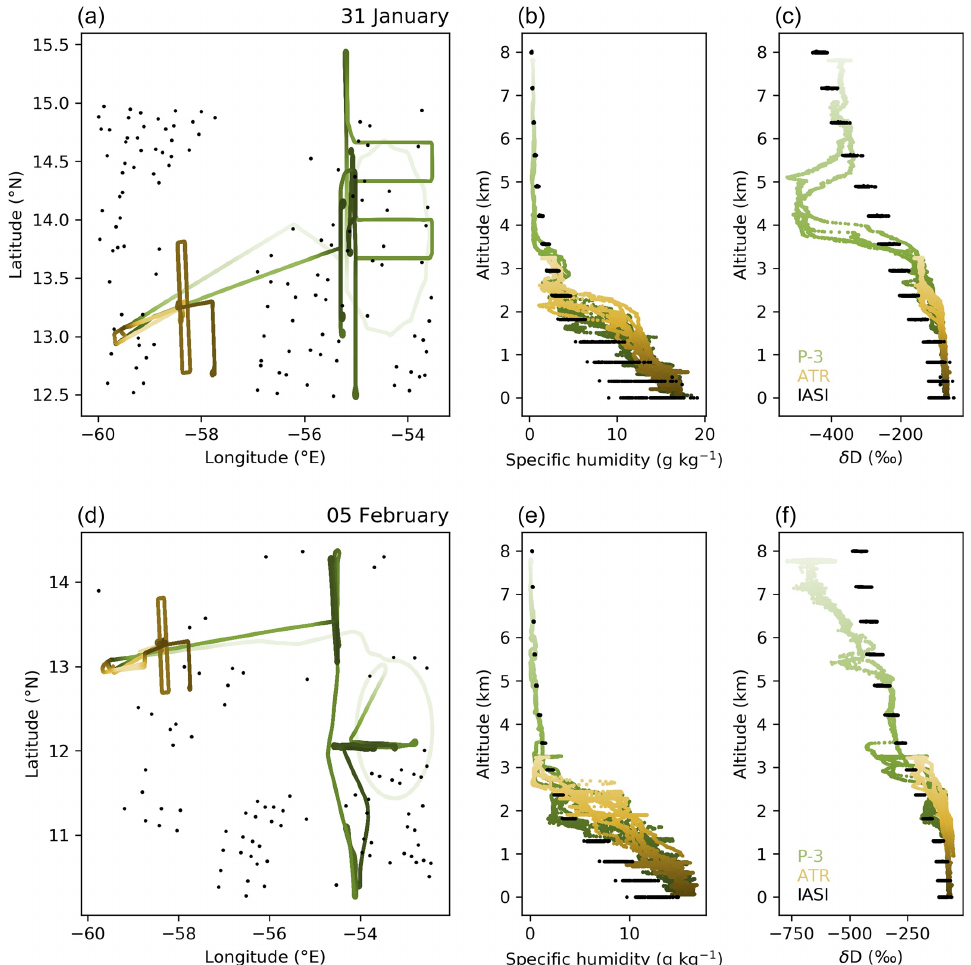
Figure 15. (a, d) Maps of the measurement locations for IASI (black, morning passes only), the ATR (yellow), and the P-3 (green) on (a–c) 31 January (DOY 31) and (d–f) 5 February 2020 (DOY 36) and measured vertical profiles of (b, e) specific humidity and (c, f) δ D from these days. Note that averaging kernels have not been applied to the aircraft observations to emphasize the different sensitivities of the various observation